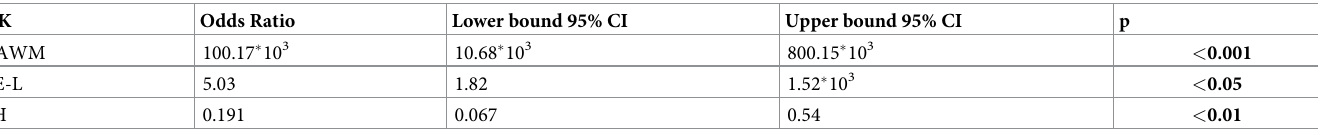
Table 3. Odds ratios MK.